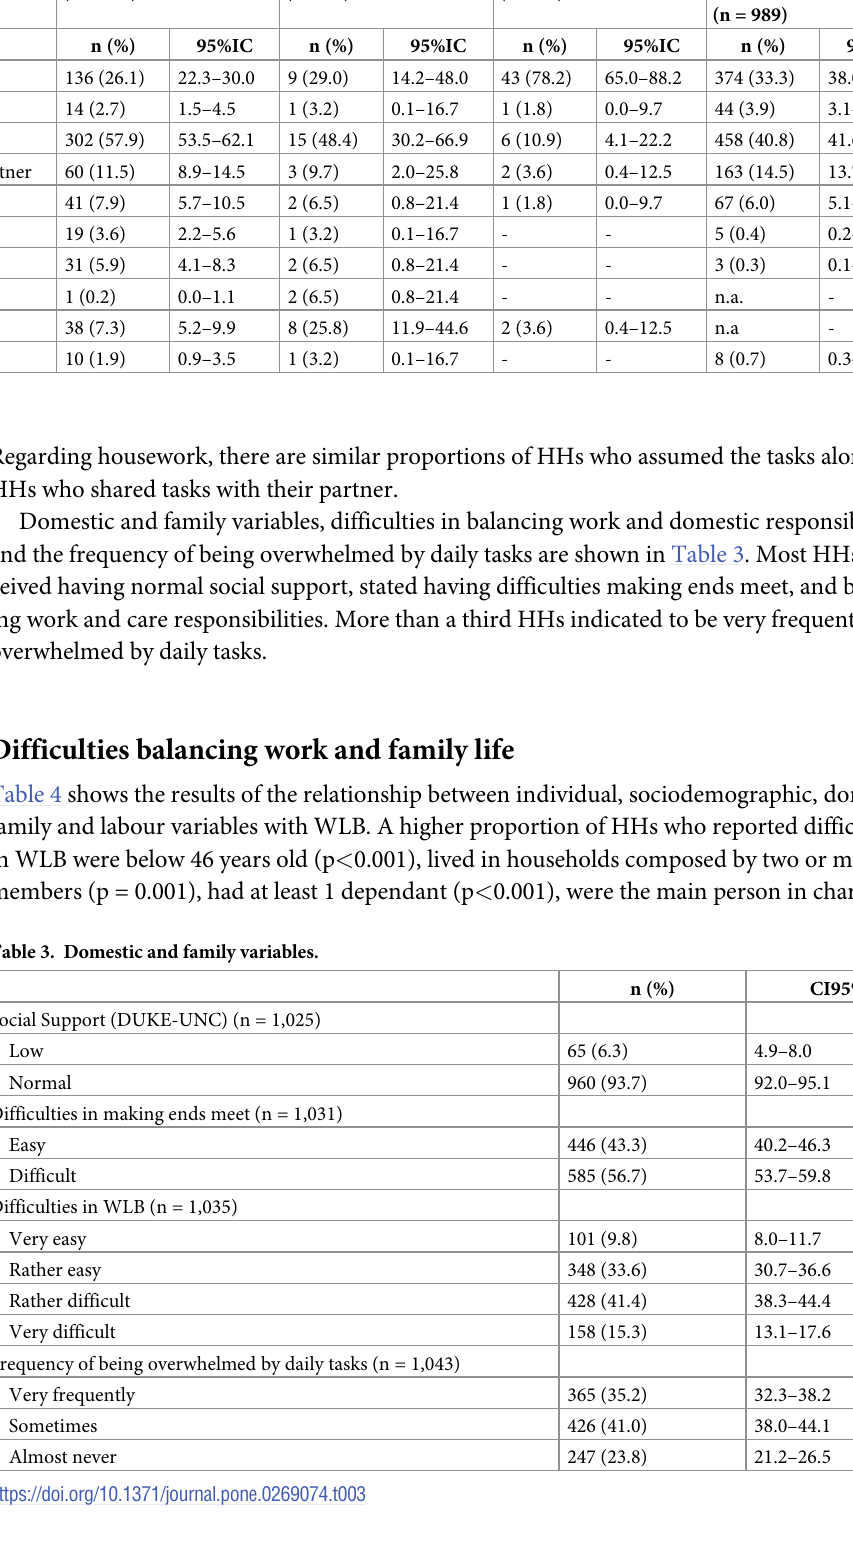
Table 2. Main person in charge of care and domestic tasks. Main person in charge of. . .